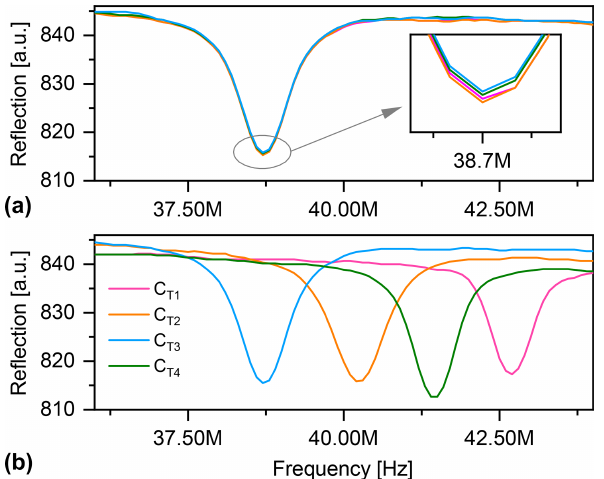
Figure 5. (a) Four consecutive acquisitions of S 11 , by the Ar- duiTaM, of a coil with a fixed C T value. The overlaid curves were acquired via one of the analogue inputs of the Arduino. The x axis covers the frequency range of the sweep. The y axis represents the magnitude of the reflected signal. The insert zooms in onto the min- imum of the curves. (b) S 11 of the same coil with four arbitrarily different C T values.